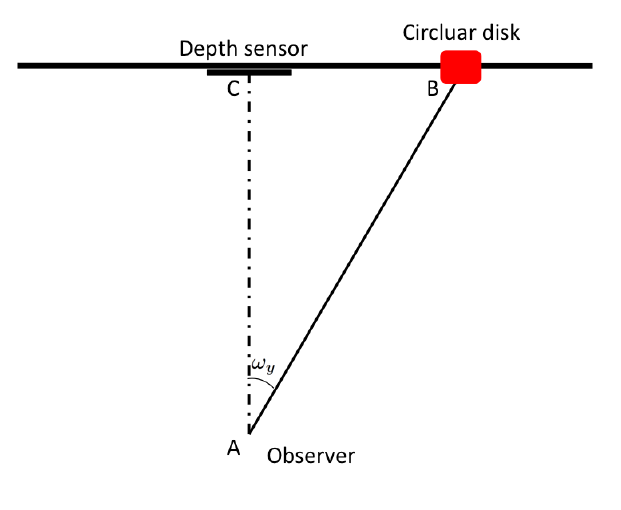
Figure 3. A scheme of the gaze estimation solution.